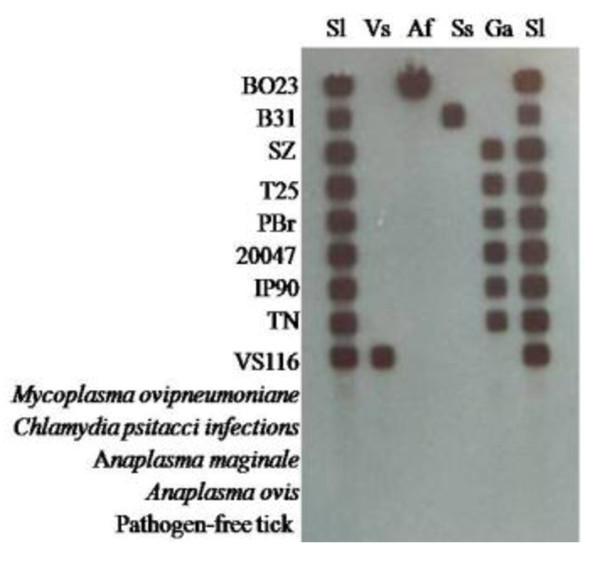
Reverse line blot (RLB) assay specificity test for Borrelia burgdorferi. Sl: Probe of Borrelia burgdorferi sensu lato; Ga: Probe of Borrelia.garinii; Ss: Probe of Borrelia.burgdorferi sensu stricto; Af: Probe of Borrelia. afzelii;Vs: Probe of Borrelia. valaisiana; row 1-14: BO23: Borrelia. afzelii; B31: Borrelia.burgdorferi sensu stricto; SZ, T25, PBr, 20047, IP90, TN: Borrelia. garinii;VS116: Borrelia. valaisiana; Mycoplasma ovipneumoniane, Chlamydia psittacii infections, Anaplasma marginale, Anaplasma ovis and pathogen-free tick DNA as negative control.